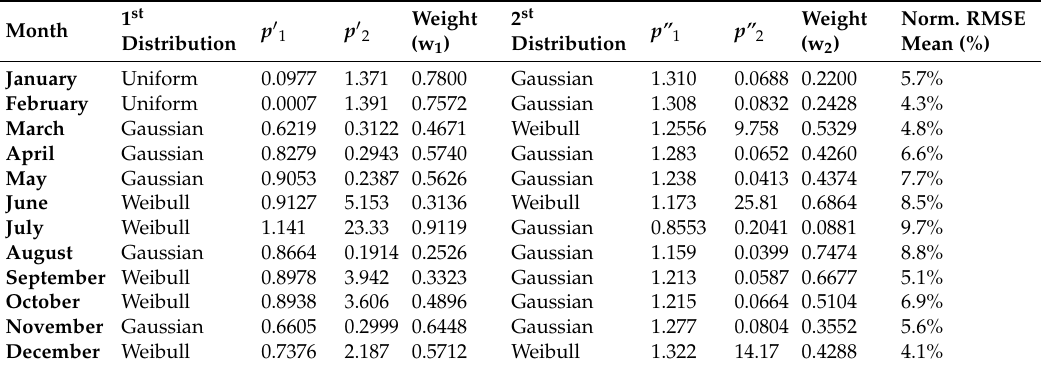
Table 2. Mixtures of distributions resulting from the analysis of K m ( p 1 1 , p 1 2 , p ” 1 and p ” 2 are defined in Table 1 and w 1 and w 2 in Equation (11)). Root mean square error: